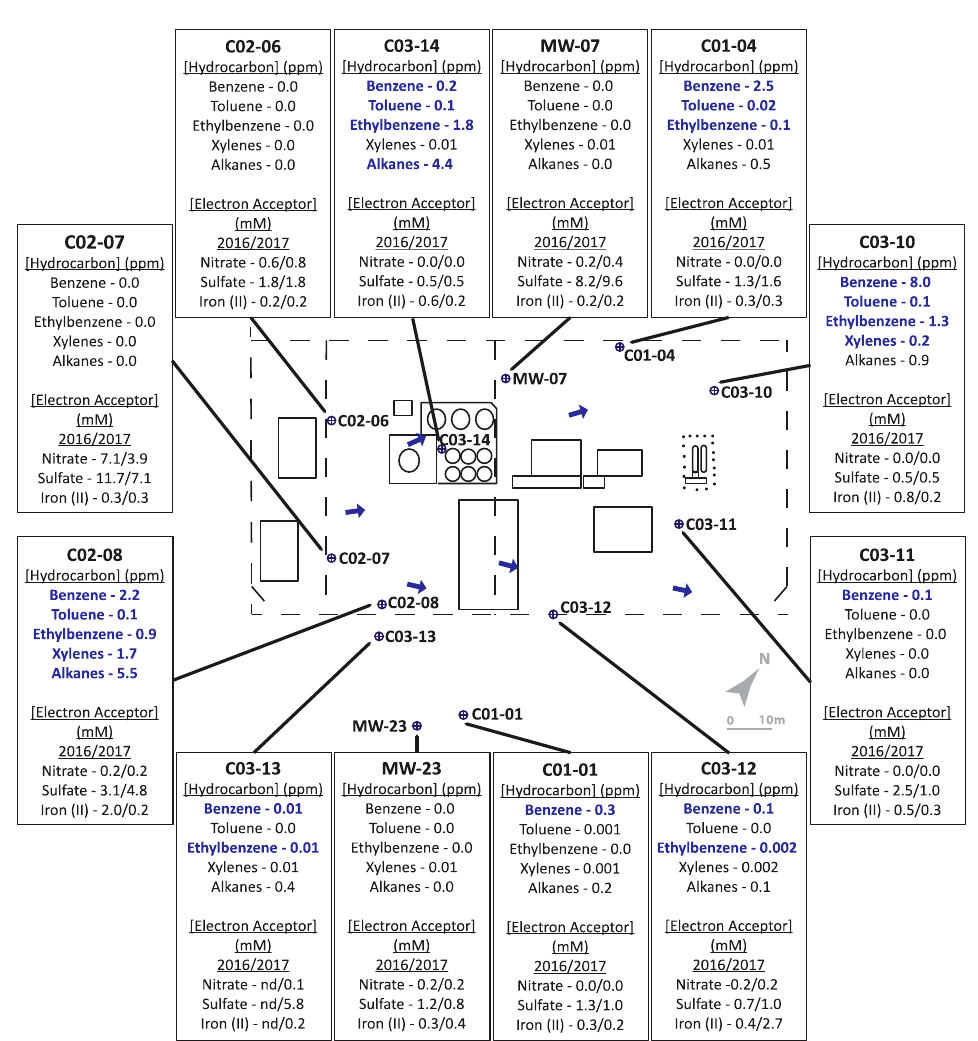
Figure 1. Schematic of Site A, with pop-outs summarizing hydrocarbon concentrations (analyzed in 2016 only) and indicators of potential electron accepting processes (analyzed in 2016 and 2017). Bolded text indicates hydrocarbon concentrations above allowable limits for hydrocarbons in non-drinking groundwater sources. ‘nd’ = no data available as well was not sampled.